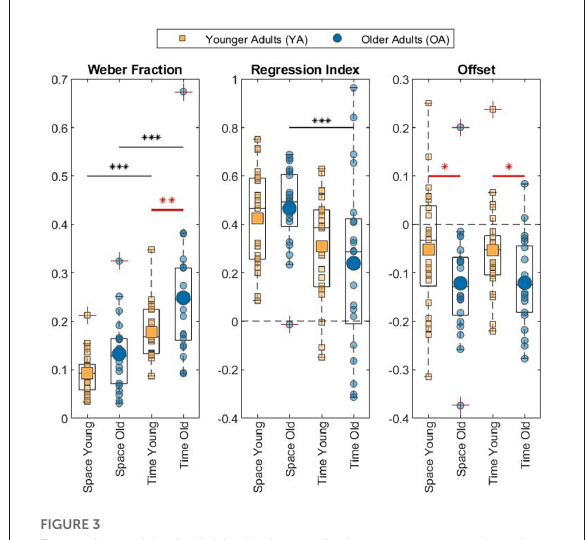
FIGURE3 Box plot with individual data of the measures related to perceptual acuity (Weber Fraction), regression to the mean (Regression Index), and Offset. The asterisks mark statistical significance. Black ones denote difference between conditions. Red ones denote difference between age groups. ∗ p < 0.05; ∗∗ p < 0.01; ∗∗∗ p <